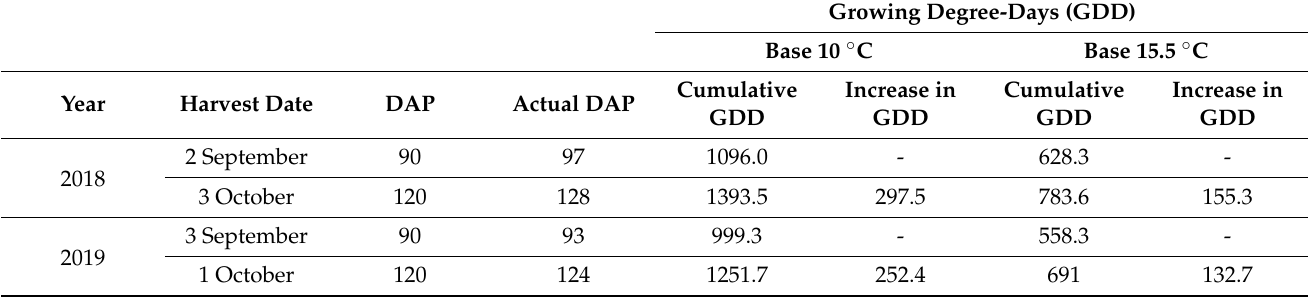
Table 1. Number of days after planting (DAP) and growing degree days accumulated using two base temperatures from the date of planting of sweet potatoes until the corresponding harvest dates.